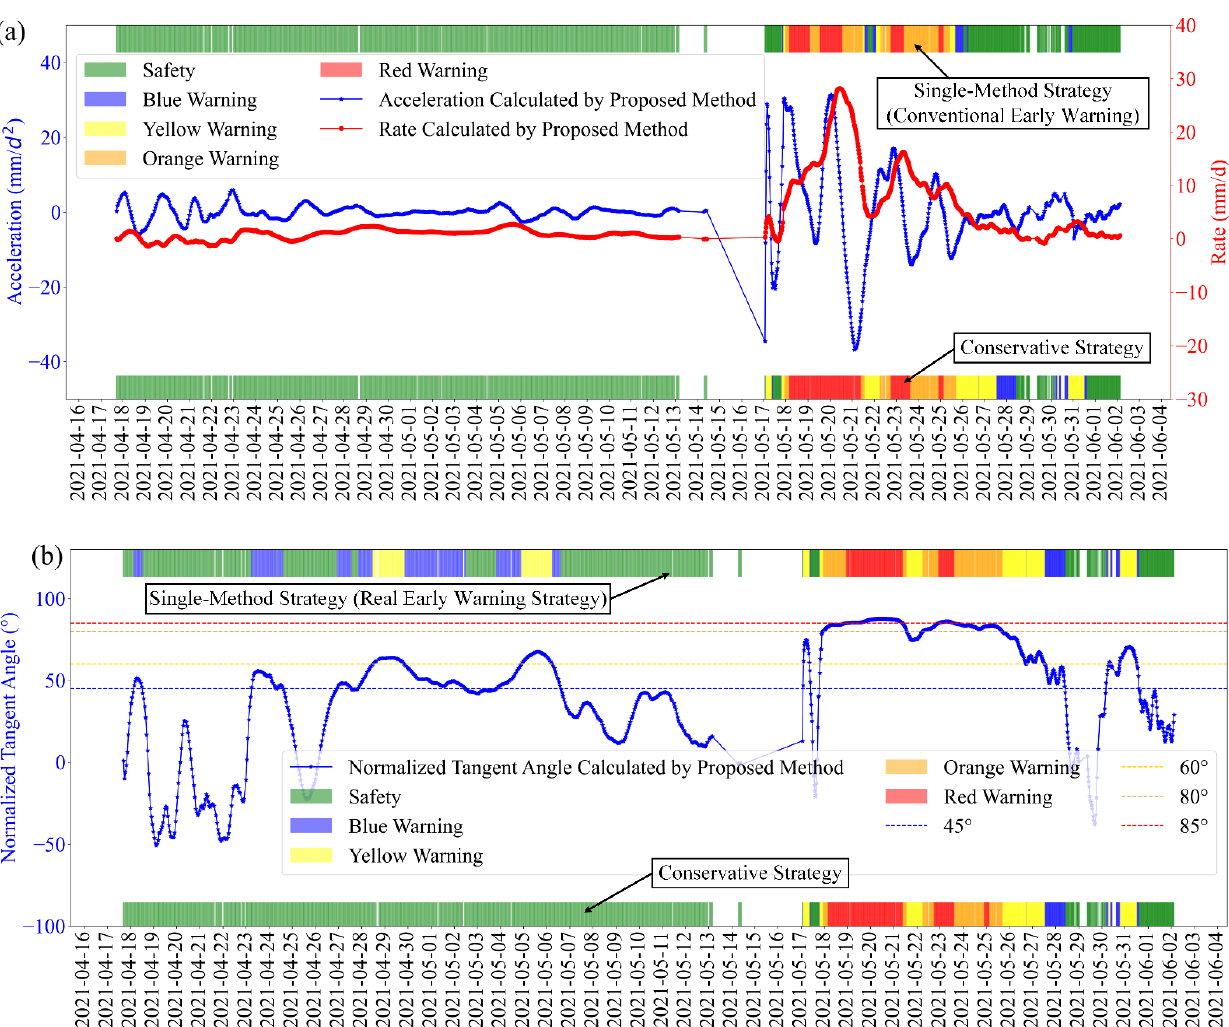
Figure 6. Early warning results of the LISHAN-DB01 monitoring station obtained by the proposed method. ( a ) Results of the conventional warning method based on velocity and acceleration. ( b ) Results of the critical sliding warning method based on the normalized tangent angle.